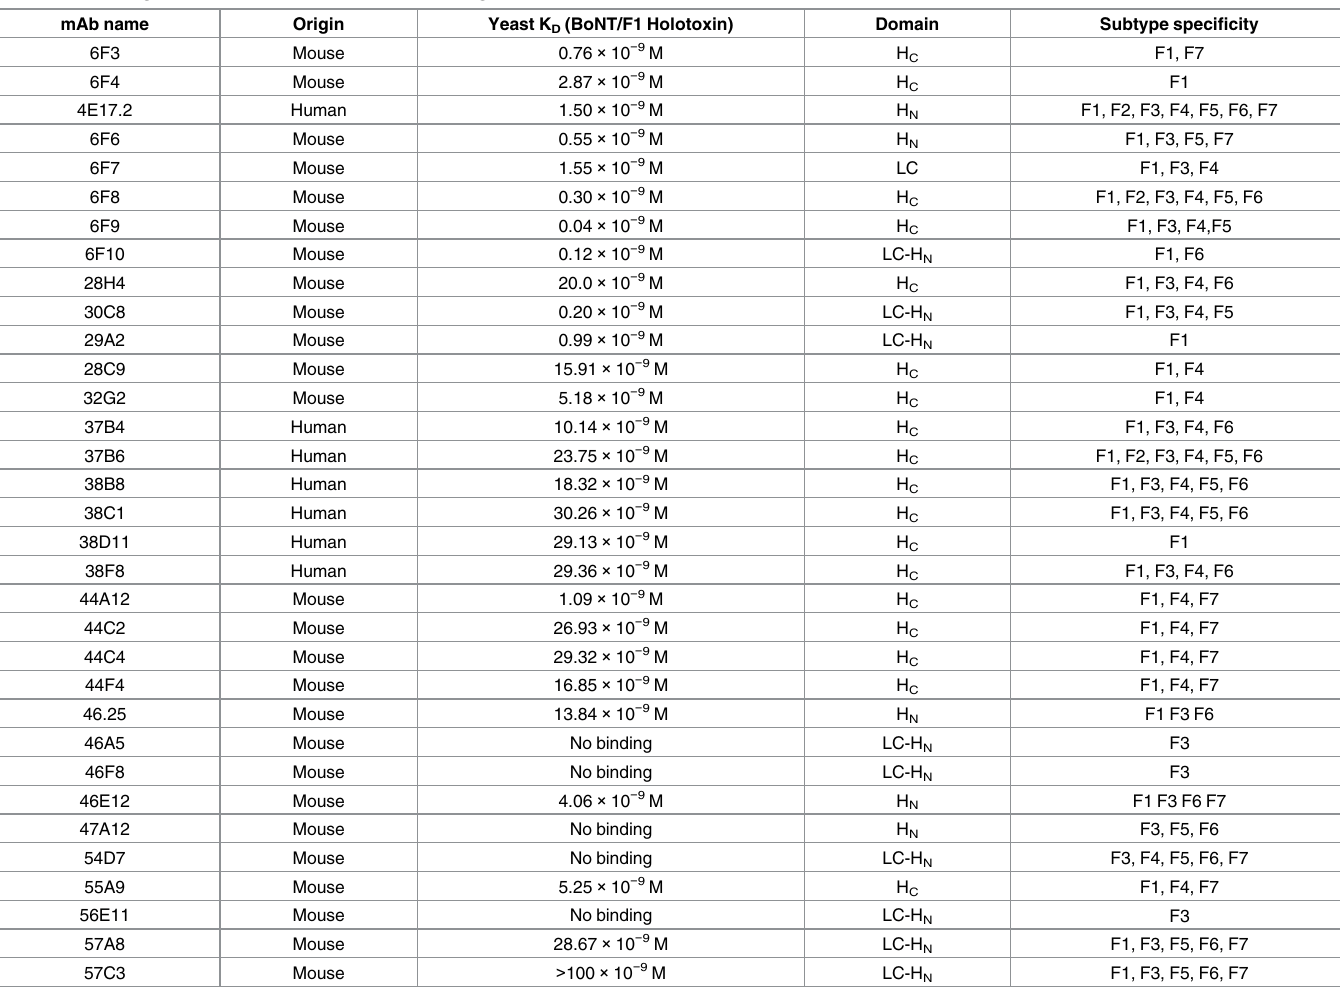
Table 1. Binding characteristics of selectedmAbs against BoNT/F. mAb name